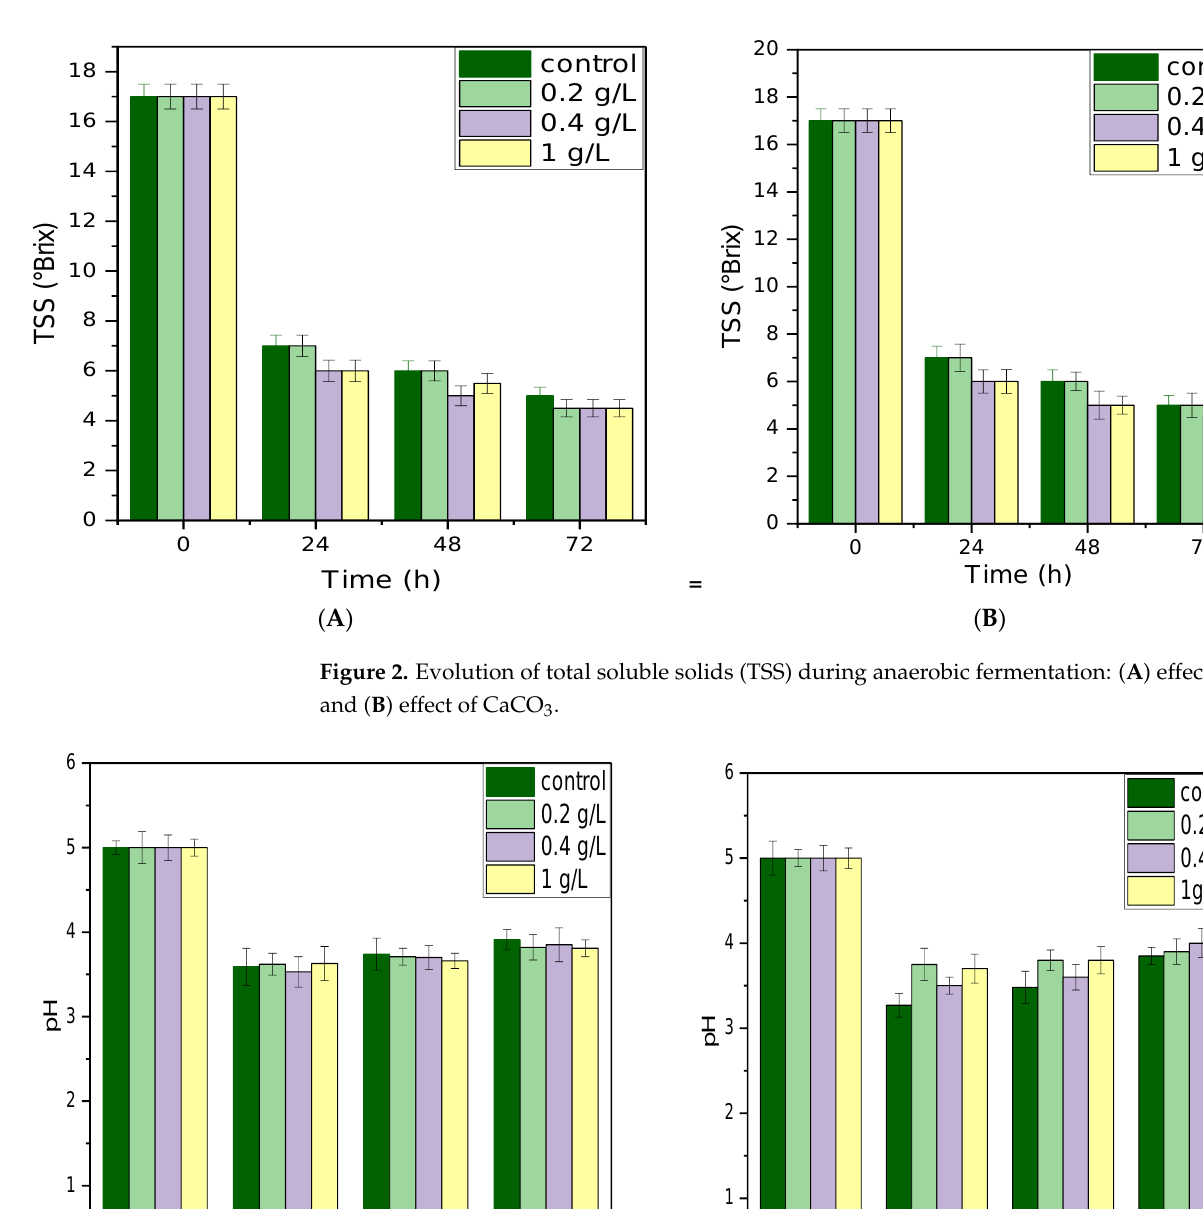
Figure 3. pH evolution during anaerobic fermentation: ( A ) effect of CaCl 2 and ( B ) effect of CaCO 3 .